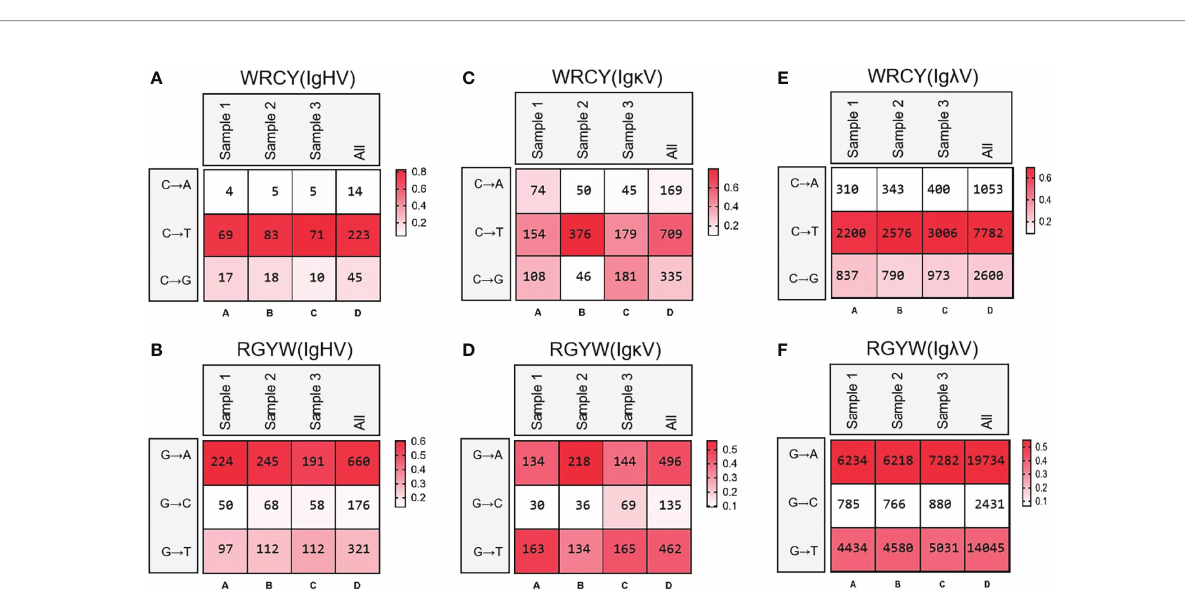
FIGURE 9 | Hot spot mutation frequency of SHM in IgH, Ig k , Ig l . (A) IgH SHM in “ WRCY ” ; (B) IgH SHM in “ RGYW ” ; (C) Ig k SHM in “ WRCY ” ; (D) Ig k SHM in “ RGYW ” ; (E) Ig l SHM in “ WRCY ” ; (F) Ig l SHM in “ RGYW ”